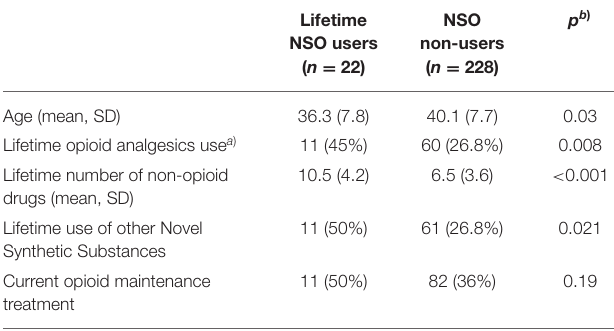
TABLE 2 | Opoid use history of patients with or without lifetime NSO